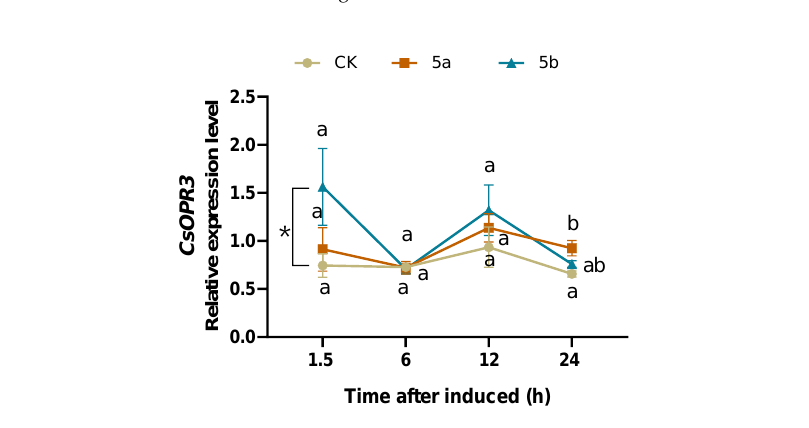
Figure 4. Mean relative expression level (±SE, n = 6) of CsOPR3 in tea leaves elicited by JA-Ile- macrolactones. Different letters indicate significant differences among treatments ( p < 0.05, Turkey’s test). The asterisk indicates significant difference between treatment and control ( p < 0.05, Student’s t test).